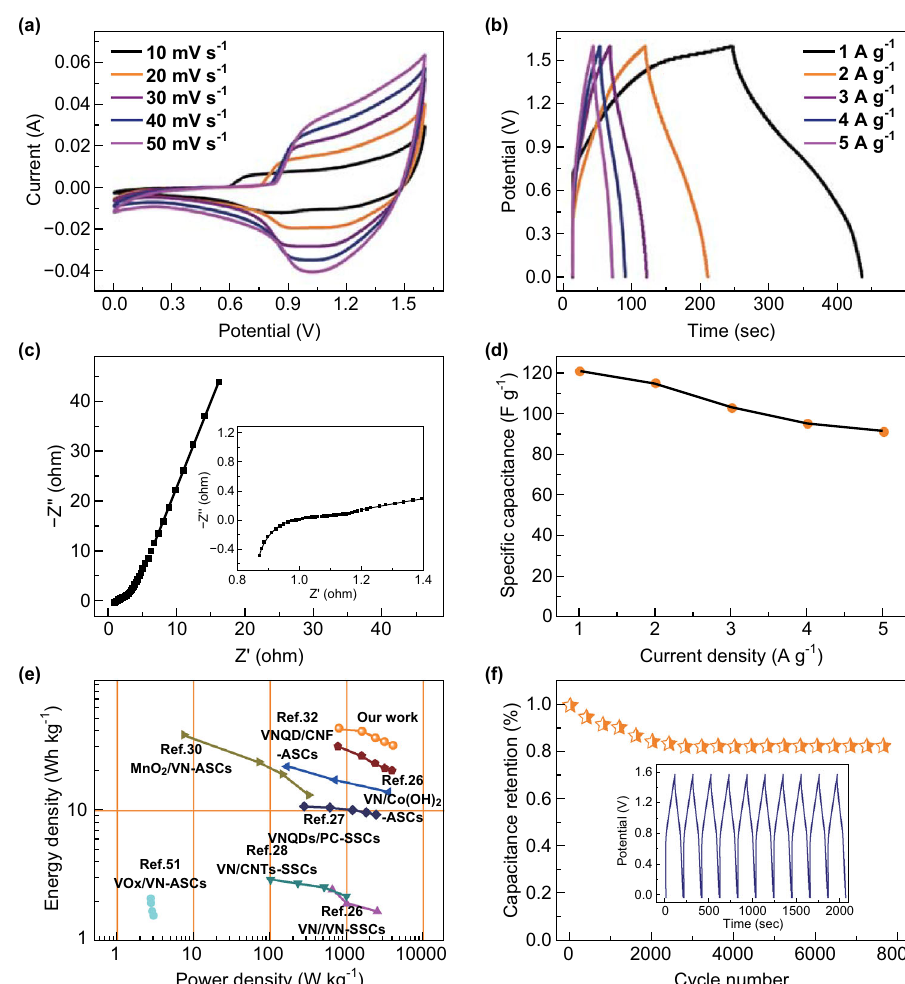
Fig. 6 The electrochemical performance of the prepared hybrid device in 6.0 M KOH: a CV, b GCD, c EIS curves, and d specific capacitances of the device at different current densities. e Ragone plots compared with previously reported VN/C-based supercapacitors. f Cycling performance of VN/C (I) at 1.0 A g -